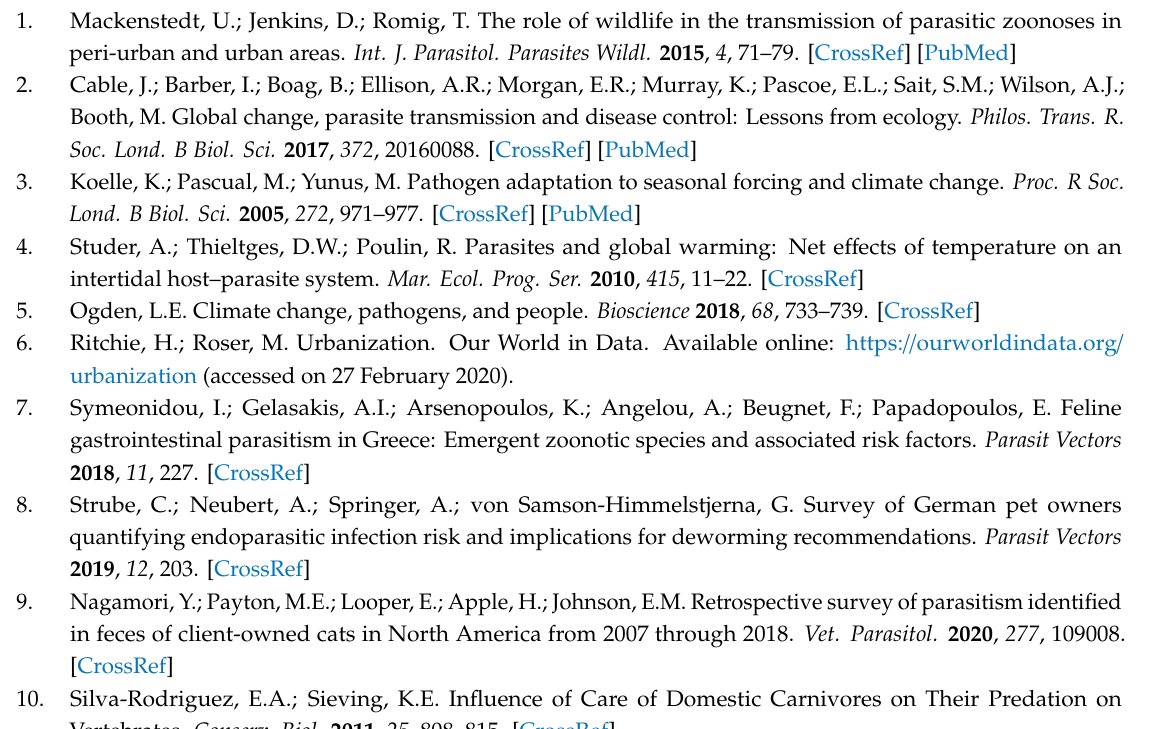
Table S1: Occurrence, mean intensity, and prevalence (%) with 95% CI of parasitic infections of cats in di ff erent habitat types; Table S2: Occurrence, mean intensity, and prevalence (%) with 95% CI of parasitic infections of cats in di ff erent sex groups; Table S3: Occurrence, mean intensity, and prevalence (%) with 95% CI of parasitic infections of cats in di ff erent age groups; Table S4: Occurrence, mean intensity, and prevalence (%) with 95% CI of parasitic infections of cats in di ff erent